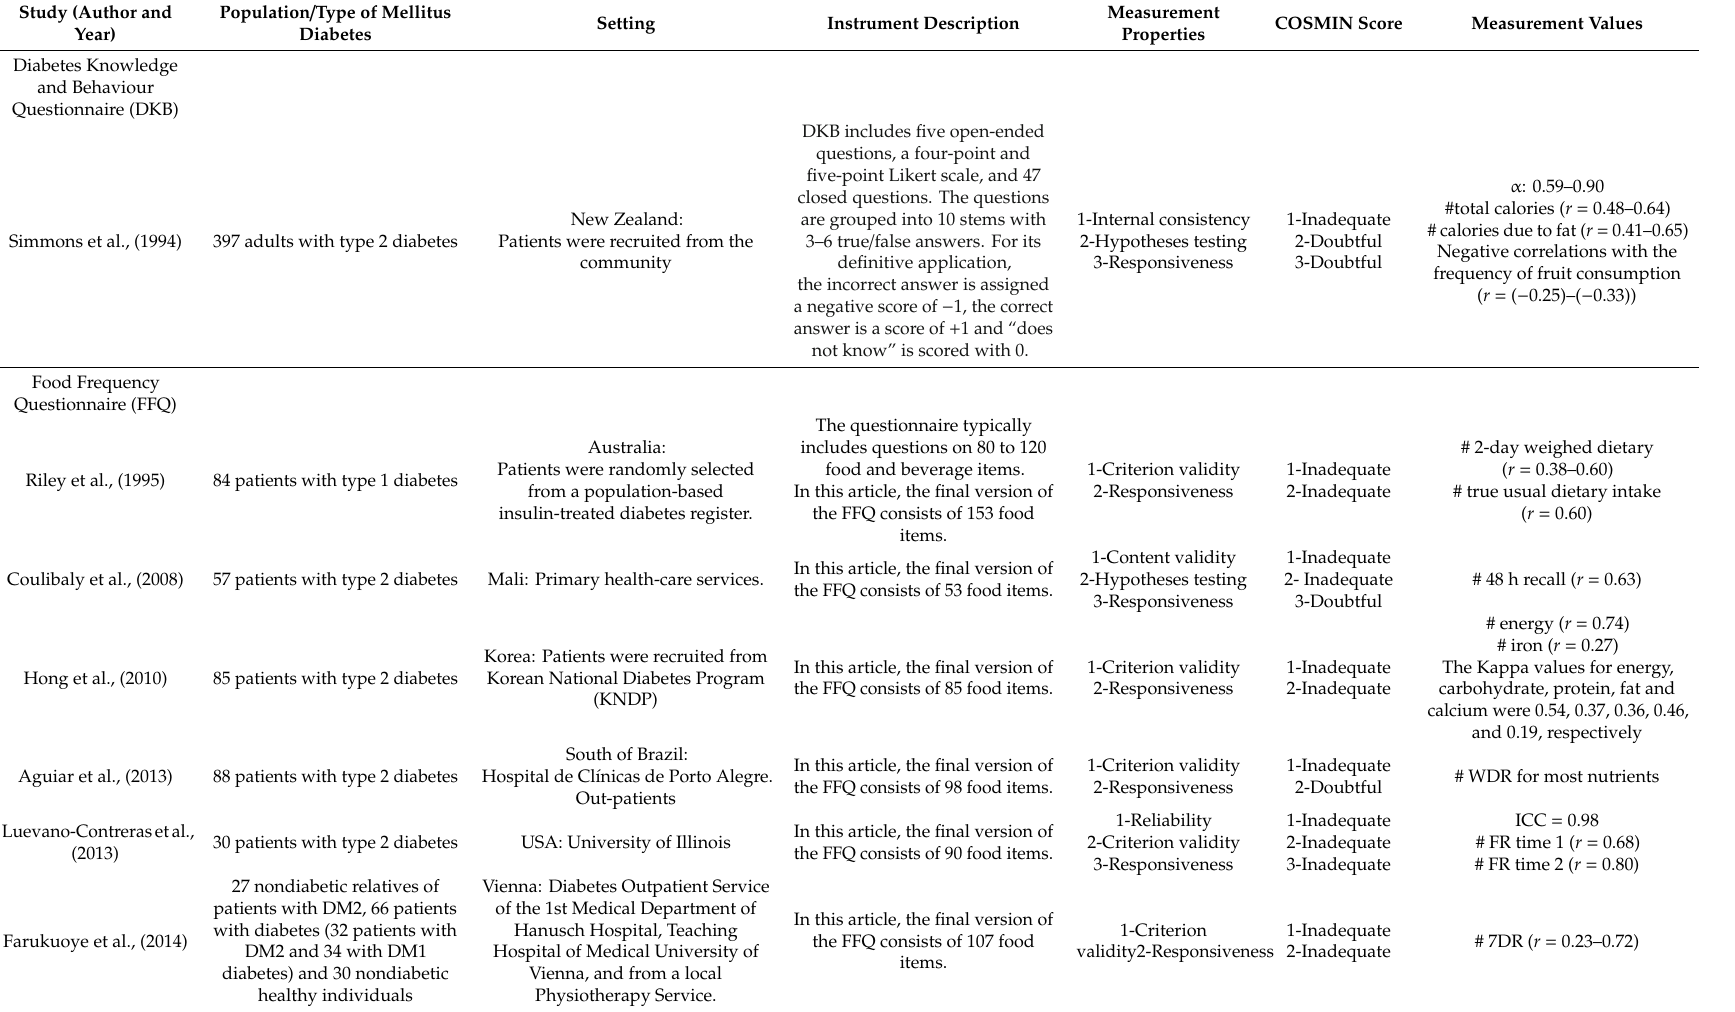
Table 2. Studies characteristics and description of status measurement instrument in